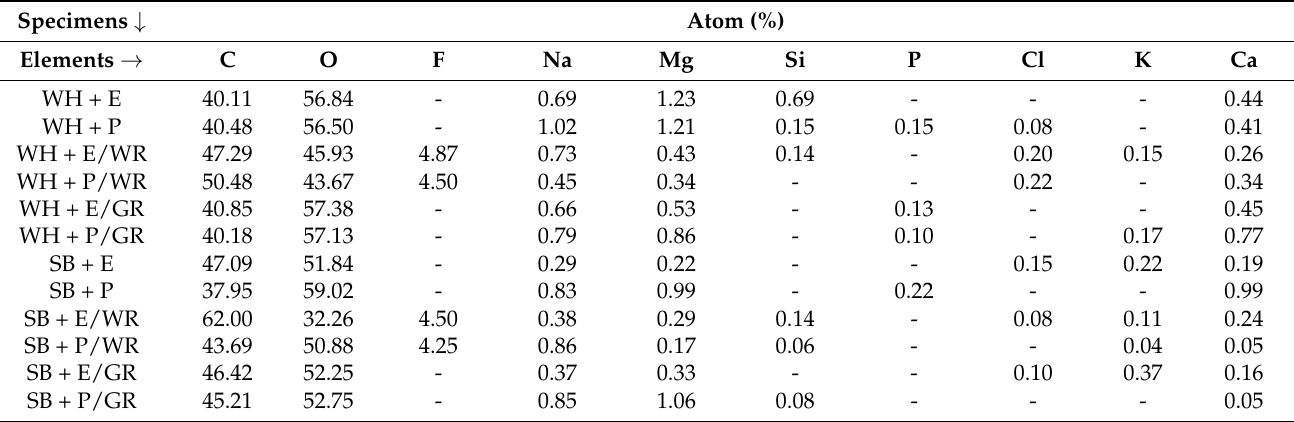
Table 2. Elemental composition of different WH and SB composite specimens before and after surface